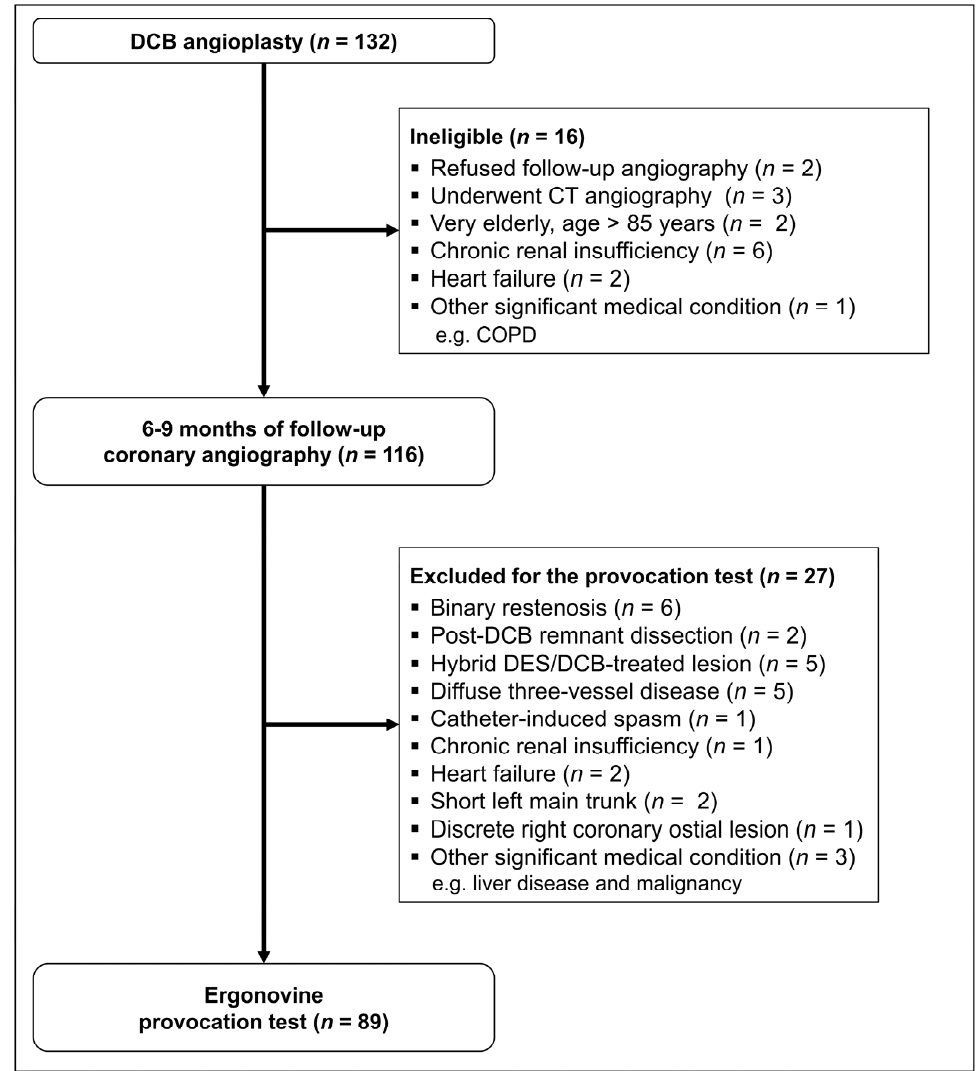
Figure 2. CONSORT flow diagram of this study. CT, computed tomography; COPD, chronic obstructive pulmonary disease; DES, drug-eluting stent; DCB, drug-coated balloon. Table 1. Clinical, lesional, and procedural characteristics of 89 patients who underwent the provo- In seven patients with documented vasospasm, RVD and DS were similar between cation test . eight DCB-treated segments and their spastic counterparts [DCB-treated vs. spastic: RVD (mm): 2.98 ± 0.56 vs. 2.61 ± 0.37, p = 0.069; DS (%): 27.64 ± 10.07 vs. 31.46 ± 13.64, p = 0.498]. However, ergonovine-induced constrictor response (%) was significantly lower in the DCB- treated segments than in the spastic segments (DCB-treated vs. spastic: − 47.4 ± 30.4% vs. − 84.5 ± 14.7%, p = 0.017, Figure 3C). The prevalence of segments showing significant vasoconstriction (>50%) was as follows: control vs. DCB-treated vs. spastic segments: 0% vs. 8.5% vs. 29.2%, respectively. Further, in the analysis of 27 patients with vasospastic features (30 DCB-treated lesions), DCB-treated segments showed less constrictor response compared to the spastic counterparts (DCB-treated vs. spastic: constrictor response (%): − 40.0 ± 21.1 vs. − 66.0 ± 17.8, p < 0.001, Figure 3D), despite their similarities in RVD and DS (DCB-treated vs. spastic: RVD (mm): 2.83 ± 0.49 vs. 2.65 ± 0.44, p = 0.109; DS (%): 24.19 ± 0.97 vs. 24.66 ± 12.53, p =